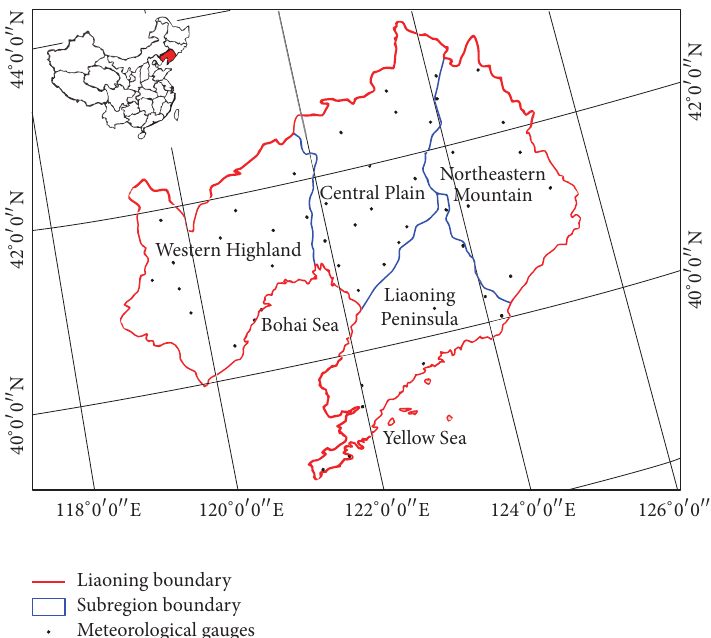
Figure 1: Geographical location of Liaoning in China, spatial distribution of four subregions in Liaoning province, and the selected meteorological stations in each subregion. Data were provided by Liaoning Provincial Meteorological Bureau and Hydrographic